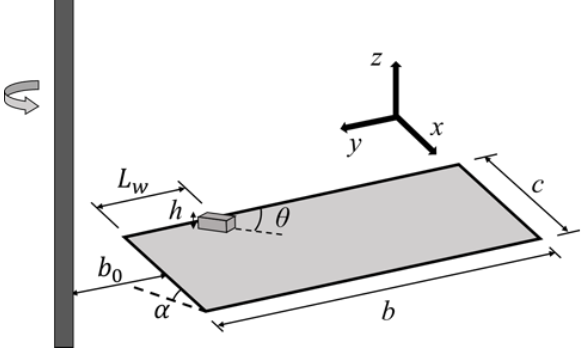
Figure 1. The schematic of the test model with an alula-VG used in this study. The flow field measurements were all conducted in an 1800 mm × 800 mm × 900 mm glass-walled water tank. The wing models, mounted on the rotary shaft at different angles of attack (10 ◦ , 25 ◦ pre-stall and 45 ◦ post-stall), were placed at the mid-depth of the tank filled with water. The minimum tip clearance with respect to the tank wall was 3.54 c to minimize wall interference [23]. The azimuthal position of the wing followed a smoothed linear ramp